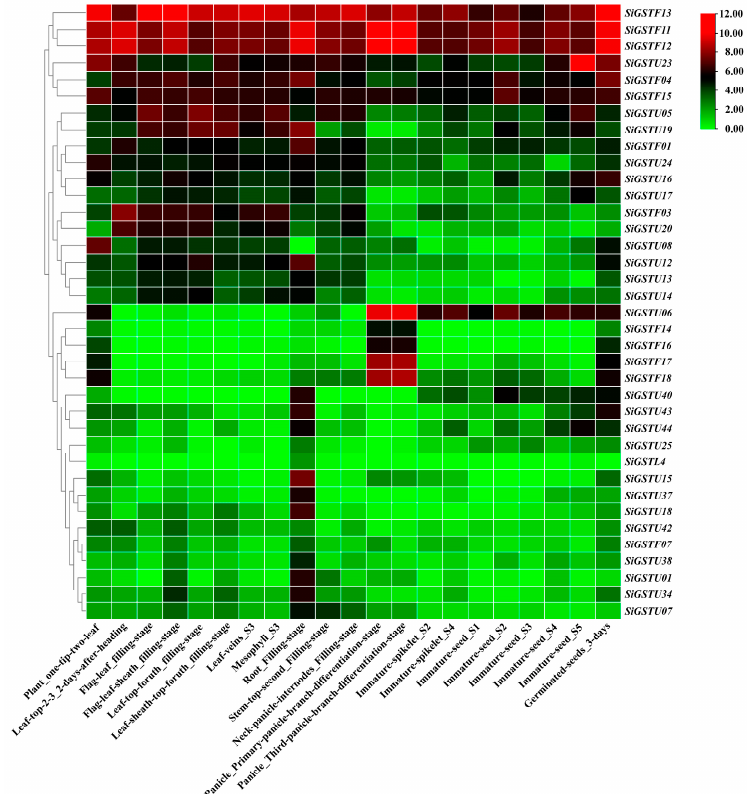
Figure 5. Relative expression patterns (FPKM value) of GST genes involved in 21 tissues of foxtail millet. The FPKM values of SiGST genes in different tissues were obtained from the Setrari italica Multiomics database (http://foxtail-millet.biocloud.net/home, accessed on 8 June 2022). The color bar represents log 2 expression levels (FPKM), with red indicating high gene expression levels and green indicating low gene expression levels.